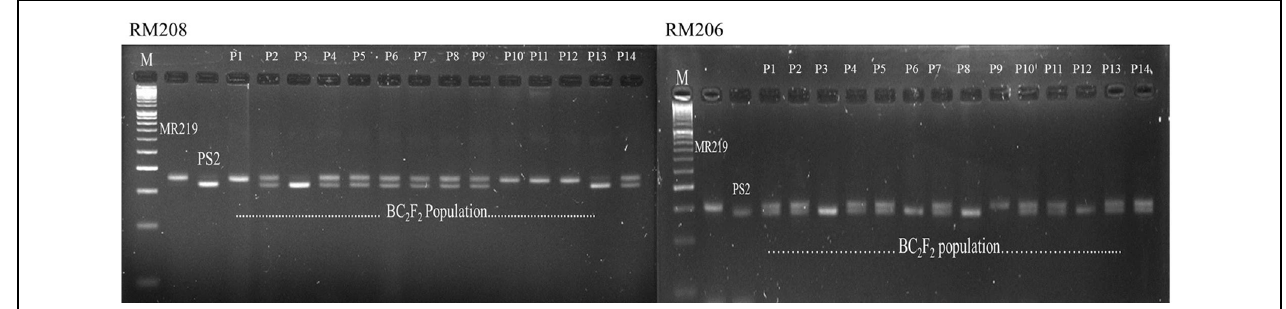
FIGURE 1 | Genotyping of blast resistant improved homozygous lines using tightly linked marker RM208 and RM206.